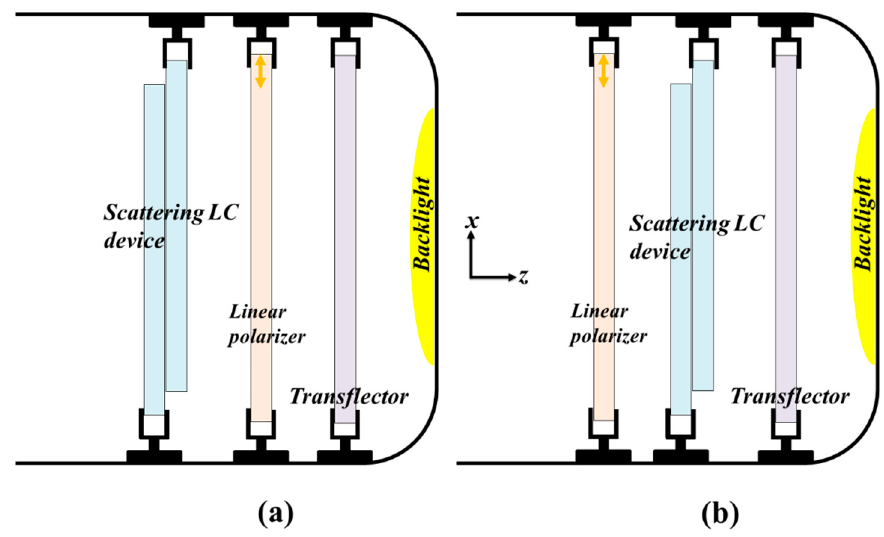
Figure 2. Configurations of ( a ) ST-TRLCD#1 and ( b ) ST-TRLCD#2. Both comprise one scattering liquid crystal (LC) device, one linear polarizer, and one transflector. The main di ff erence in configuration between both is the arrangement of the linear polarizer and the scattering LC device. Orange arrows plotted in the linear polarizers represent their transmissive axes.